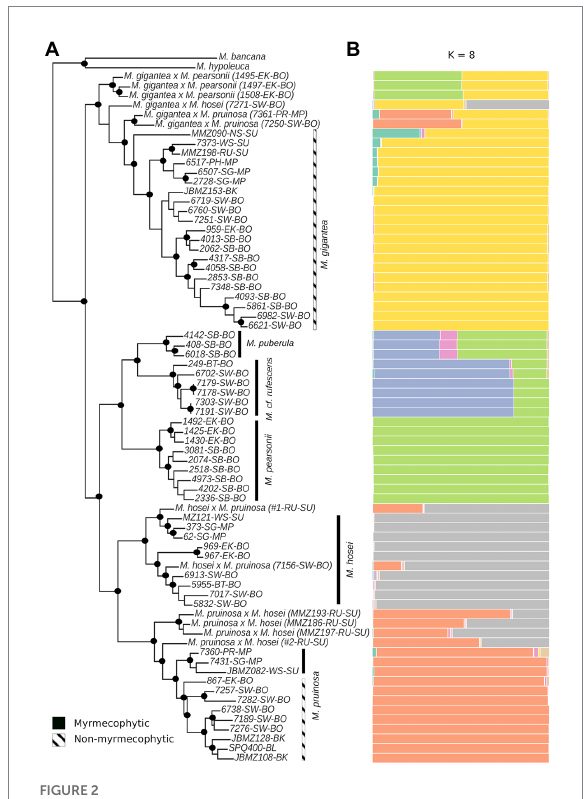
FIGURE 2 Maximum likelihood tree construction of the 72 Pruinosae individuals using GBS data. Nodes marked with a black solid circle indicate those that received bootstrap support >95%. Myrmecophytic clades are marked with a solid black bar while non-myrmecophytic clades are marked with a hatched black and white bar. Individuals are represented by their accession numbers along with their regions of collection which are indicated by abbreviations as in Figure 1: BK, Bangka; BL, Belitung; BT, Belait (Brunei); EK, East Kalimantan; NS, North Sumatra; PH, Pahang; PR, Perak; RU, Riau; SB, Sabah; SG, Selangor; SW, Sarawak; WS, West Sumatra. Major regions of Borneo, Malay Peninsula, and Sumatra to which the aforementioned regions belong are abbreviated as BO, MP, and SU respectively, and are also included in the names (A) . K = 8 STRUCTURE plot for the 72 individuals obtained using GBS-derived SNP data (B)